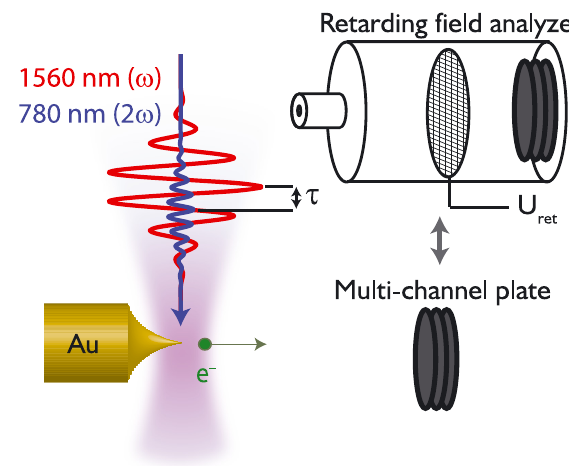
Figure 1: Experimental setup. Few-cycle two-color laser pulses emit electrons from a nanometer sharp gold needle tip. The emitted yield is recorded by a multi-channel plate detector as a function of the delay 𝜏 between the fundamental field and its second harmonic. Alternatively, energy-resolved spectra are obtained by a retarding field